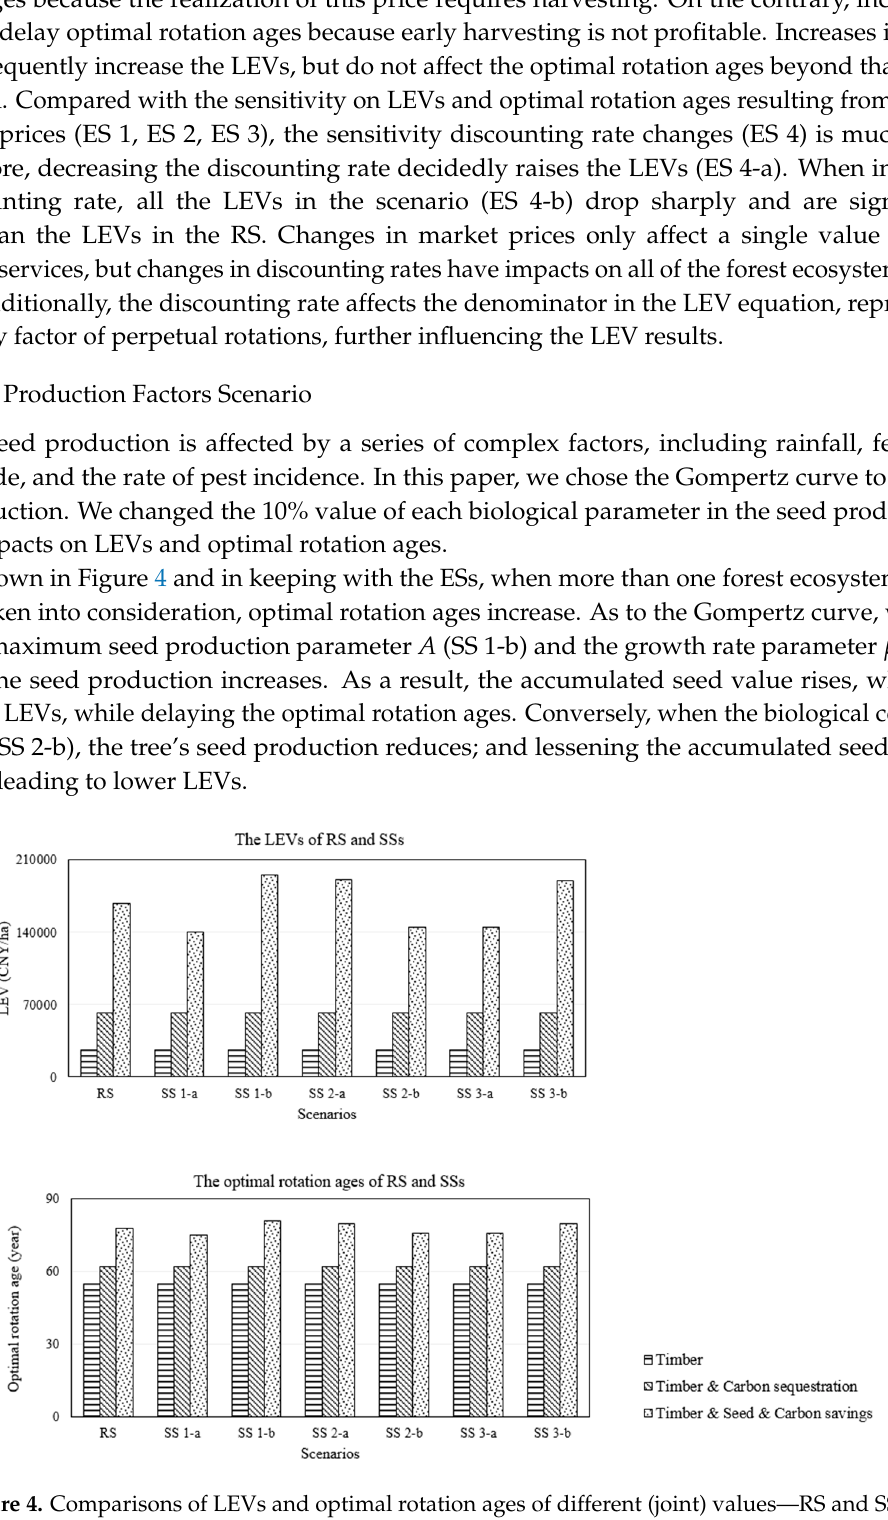
Figure 4. Comparisons of LEVs and optimal rotation ages of different (joint) values—RS and SSs.